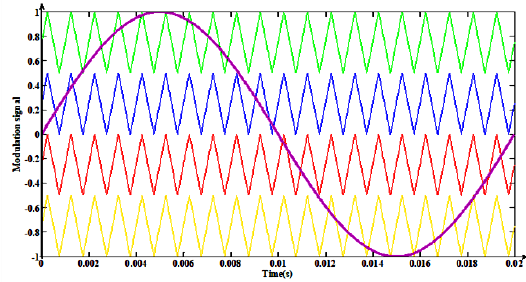
Figure 38. Conventional PWM signal.